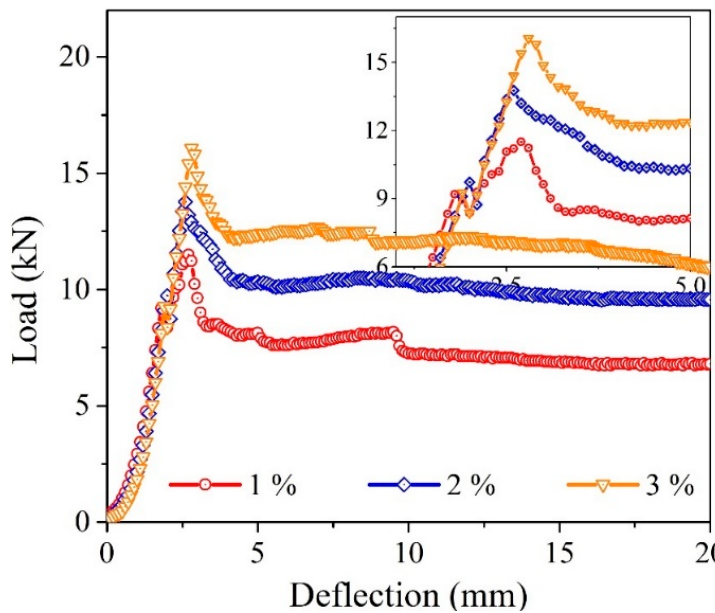
Figure 10. Load–deflection curves from the biaxial flexure test.